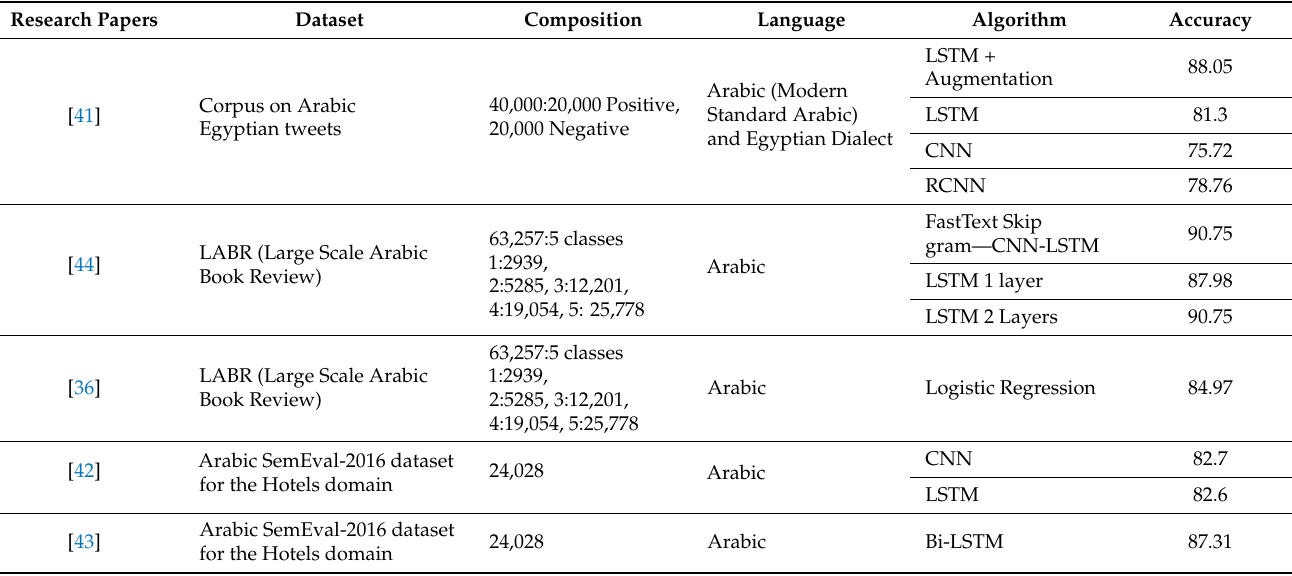
Table 1. Arabic Sentiment Classification Literature